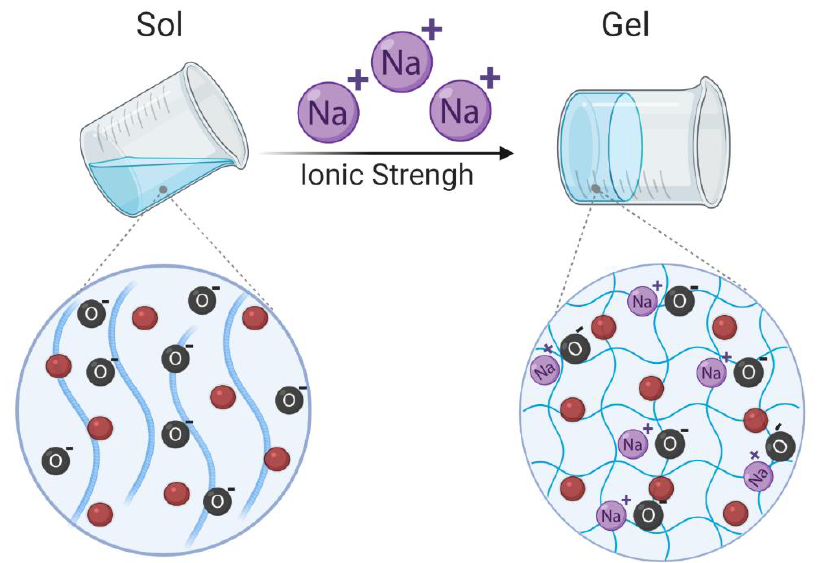
Figure 5. Schematic representation of ionic strength responsive hydrogels. Swelling of the hydrogel occurs when the ionic strength of surrounding medium increases. O—Oxygen, Na + —Sodium. The red circles represent the drugs loaded in the hydrogels. Created with BioRender.com (accessed on 15 January 2021).